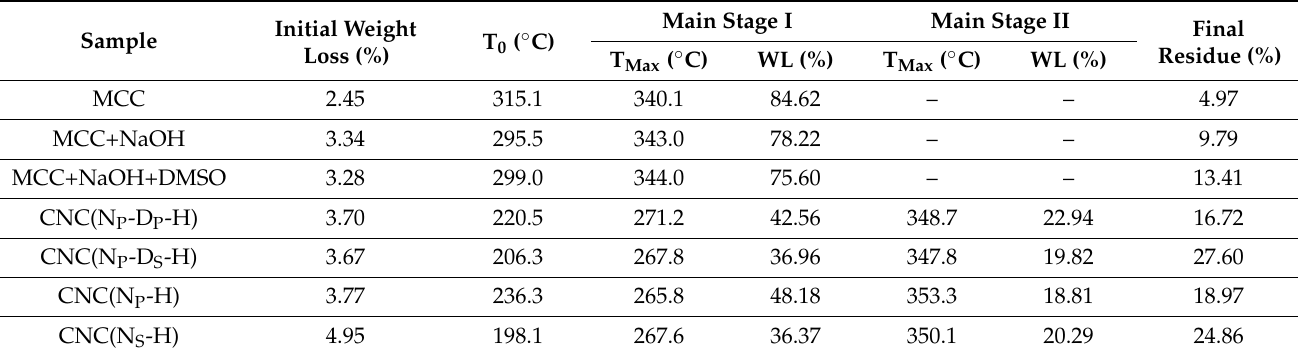
Table 2. Thermal degradation parameters of different